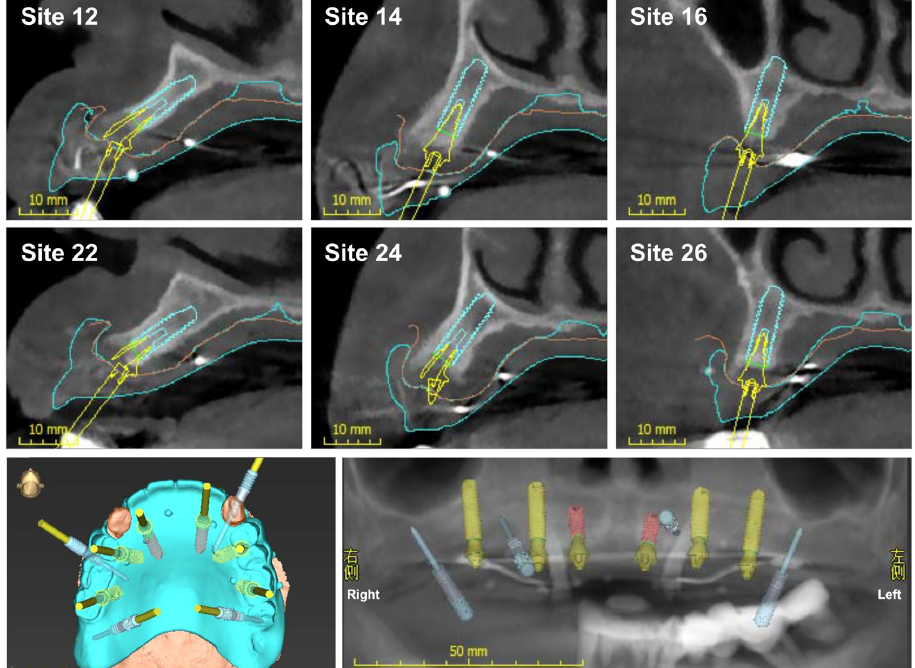
Figure 4. Virtual 3D planning positions for placing six implants and four metallic pins in the maxilla. In the panoramic radiograph, red implants show a diameter of 3.4 mm, yellow implants indicate a diameter of 4.0 mm, and blue ones represent metallic pins.